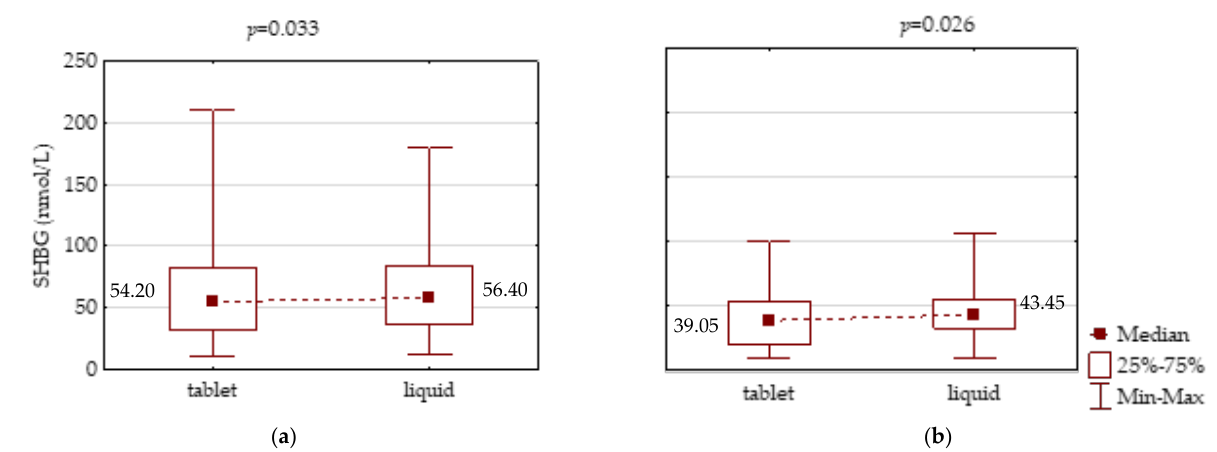
( b ) Figure 3. Comparison of fT3 serum concentration between LT4 therapy in tablet and liquid form in an equivalent dose in: ( a ) primary and ( b ) central hypothyroidism.